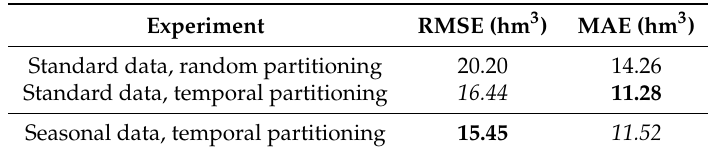
Table 7. General comparison of the experimental results in the short-term prediction of water level at Belesar reservoir. Boldface stands for the best value found in a dataset, and italic for the second